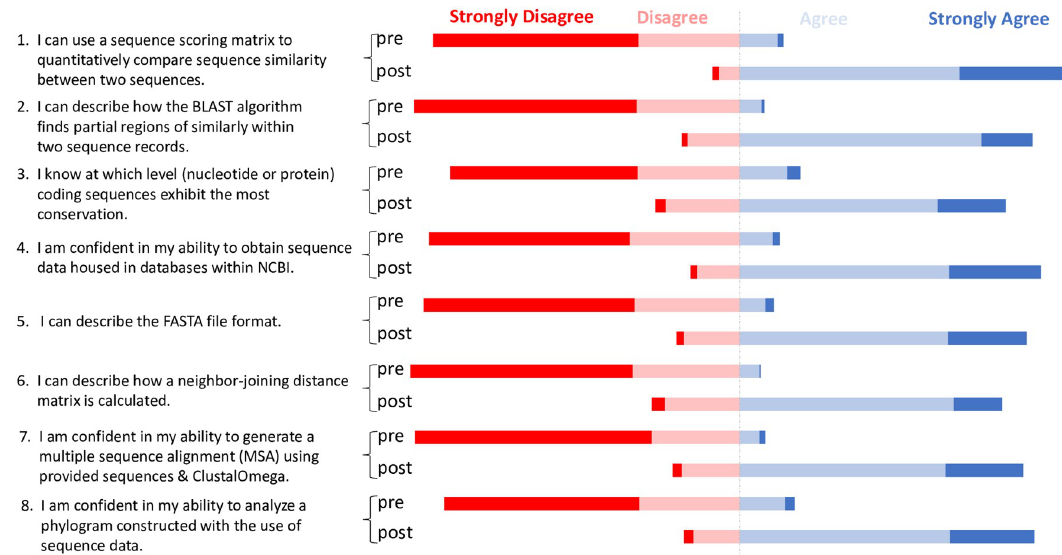
Fig 4. Student participants self-reported perceived learning gains. Retrospective pre- and post-survey aggregate data utilizing a four-point Likert-type scale is depicted as a divergent stacked bar graph. Nine cohorts of student participants (n = 362) at a diversity of institutions completed the survey instrument. All questions were statistically significant (p < 0.0001) when comparing median Likert-type scale response between retrospective pre- and post-ratings using the Wilcoxon signed-rank